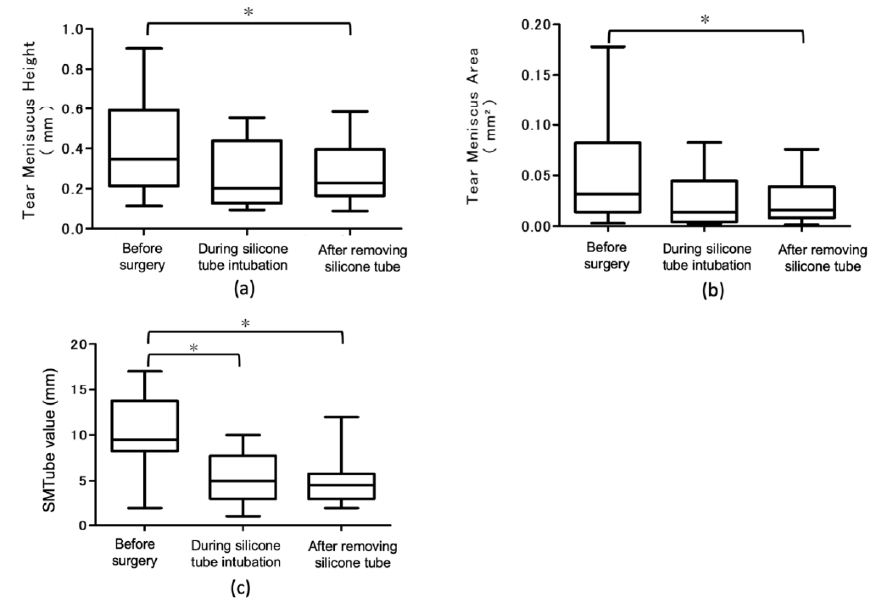
Figure 3. Time-course changes of tear meniscus height, tear meniscus area, and strip meniscometry value before surgery, during the silicone tube intubation, after removing the silicone tube. ( a ) Tear meniscus height decreased significantly after removing the silicone tube, compared to before the surgery. ( b ) The tear meniscus area decreased significantly after removing the silicone tube, compared to before the surgery. ( c ) The SMTube value decreased significantly after removing the silicone tube compared to before the surgery and during the silicone tube intubation. * p < 0.05.